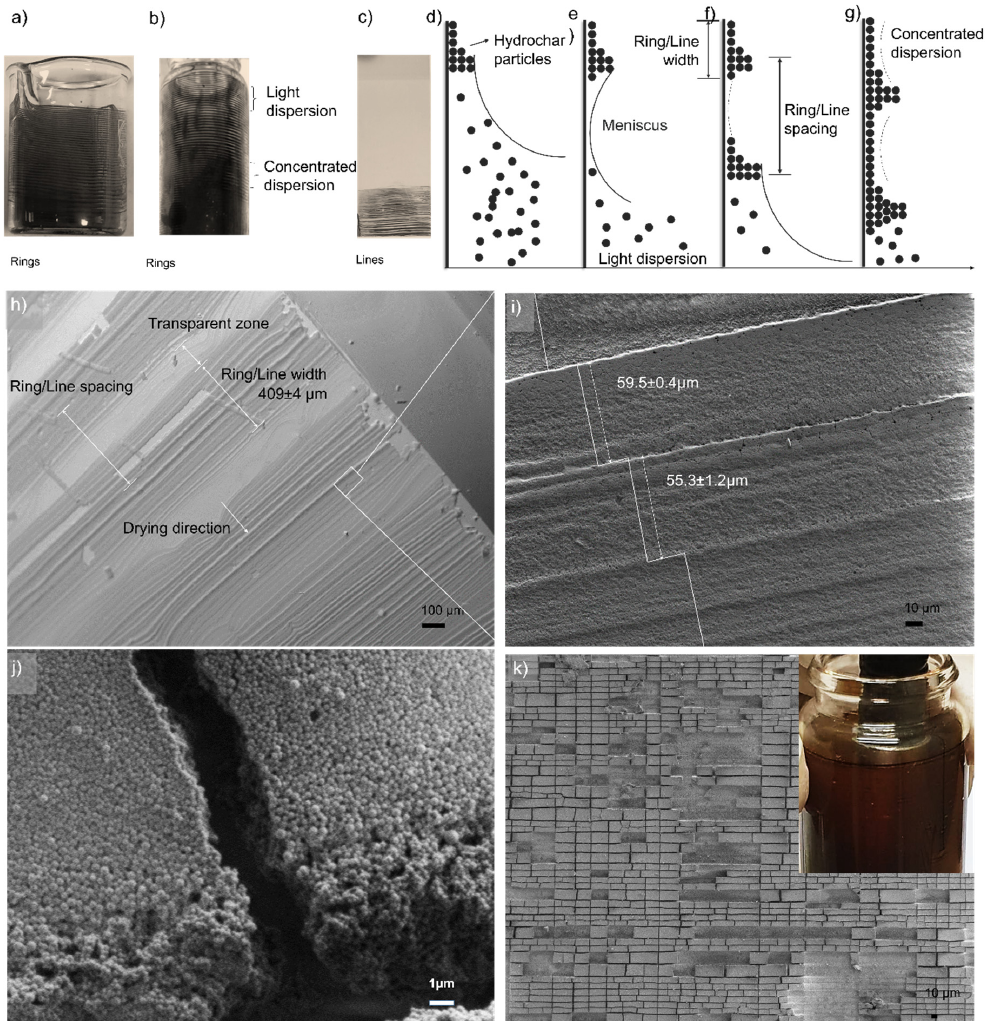
Figure 2. ( a – c ) Photographs of evaporating CH3.63-SDS show that rings could form with both cylindrical and plate geometries ( a ) in a glass beaker, ( b ) in a glass vial, and ( c ) lines on both sides of a glass plate; ( d – f ) illustration of the mechanism of the line pattern formation of the light dispersion on glass substrates (a similar figure is presented in the study by Watanabe et al. [14]. Adapted with permission from Watanabe et al., Langmuir ; published by ACS, 2009); ( g ) formation of the line patterns and the transparent layer between two adjacent lines of the concentrated dispersion on glass substrates; SEM images of CH3.63-SDS evaporation indicated; ( h ) parallel rings, ring spacing, and transparent regions; ( i ) each ring consisted of thin and stacked small layers; ( j ) each layer is assembled from spherical particles of hydrochar; and ( k ) is an example SEM image showing patterns formed in a glass vial by evaporating water from CH3.63. The insert photo presented the macro morphology of the corresponding patterns of hydrochar particles formed on the glass interface after the evaporation of water from the purified hydrochar dispersions (to see the patterns clearly, a light was inserted through the top of the